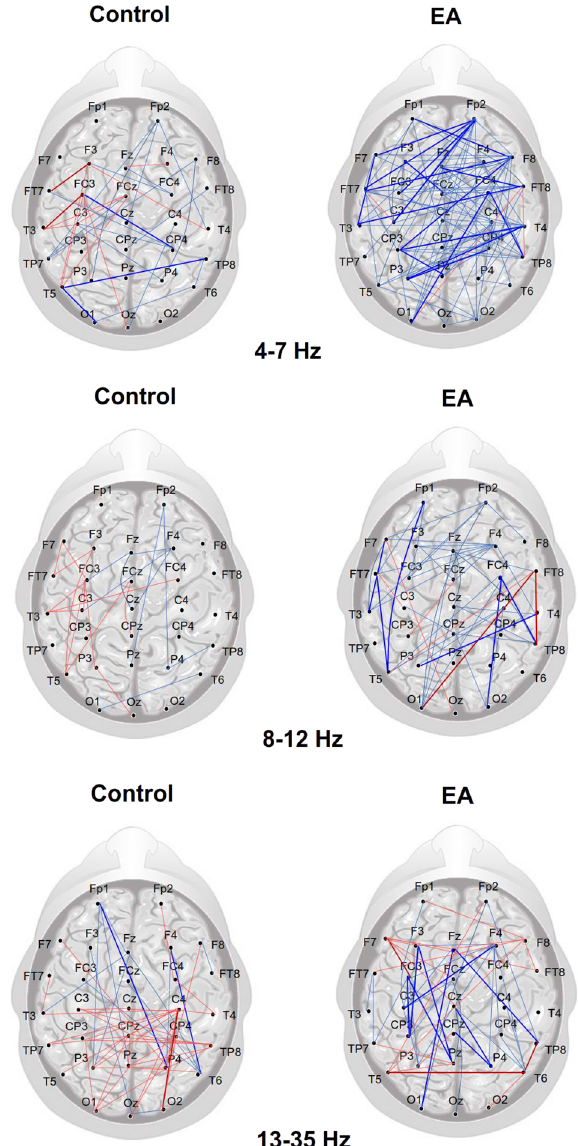
Fig. 3 The training-related changes in topology of functional connectivity at theta (4 – 7 Hz), alpha (8 – 12 Hz), and beta (13 – 35 Hz) for the control and EA groups. Greater functional connectivity in the post-test than in the pre-test is labeled with bold ( t 17 > 2.898, p < 0.005) and light ( t 17 > 1.740, p < 0.05) red wires. Smaller functional connectivity in the post-test than in the pre-test is labeled with bold ( t 17 > − 2.898, p < 0.005) and light ( t 17 > − 1.740, p < 0.05) blue wires. There are visible differences in training-related functional connectivity between the EA and control groups. In contrast to the control group, the EA group generally exhibited a greater number of changes in supra-threshold connectivity ( p < 0.005) following postural training, especially for decreases in connectivity strength of the theta and alpha bands in the and ankle movements explained the reliance on the ankle strategy for stabilometer stance 32,33 . With traditional visual feedback, the